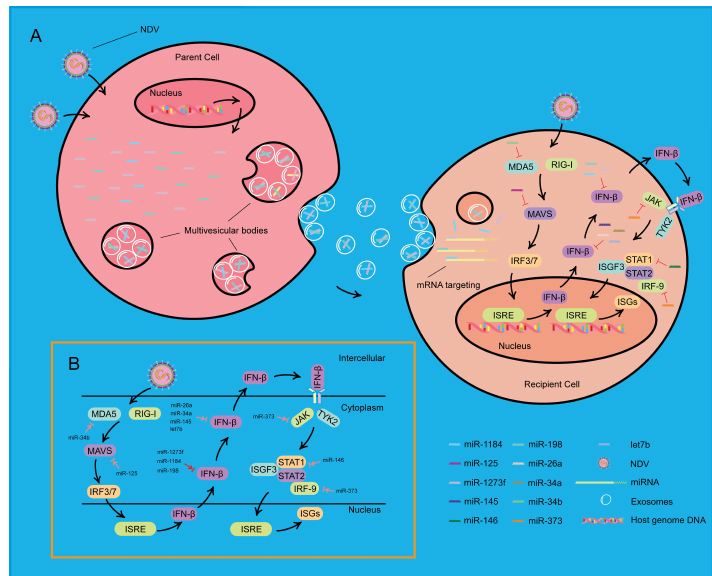
Figure 8. Schematic showing that exosomes carrying miRNAs promote NDV infection. ( A ) During NDV infection, three miRNAs changed their expression and loaded into exosomes derived from multivesicular bodies (MVBs) of a NDV-infected HeLa cell, called the “parent cell”. MVBs fuse with the plasma membrane and release exosomes that contain these miRNAs. In another HeLa cell, called the “recipient cell”, these three miRNAs, transferred by exosomes, a ff ect the IFN- β mRNA and further a ff ect the expression of ISGs, eventually resulting in increasing NDV replication. ( B ) MicroRNAs may be involved in the IFN I pathway during NDV infection. MicroRNAs marked by the red arrow were found in the current research, and microRNAs marked by the pink arrow were found in other virus infections and remain to be